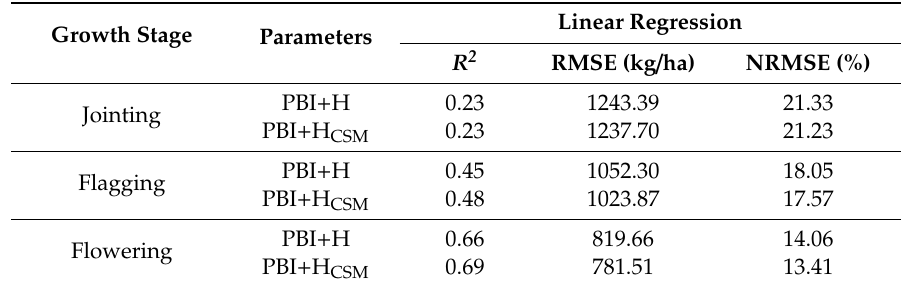
Table 3. Results of yield estimation obtained using a combination of the PBI and H, and a combination of the PBI and H CSM , for di ff erent growth